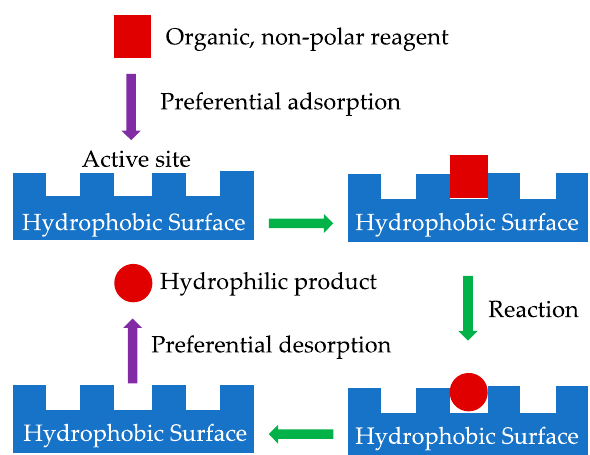
Figure 2. Simple scheme that illustrates preferential adsorption and desorption.